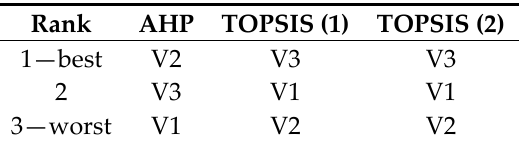
Table 2. Final ranking of alternatives in used methods: analytic hierarchy process (AHP), technique for order preference by similarity to ideal solution (TOPSIS) (1), using AHP weights and TOPSIS (2) using rank weights. ( Source: own